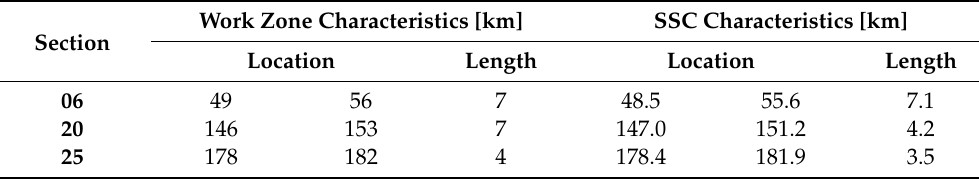
Table 2. Basic characteristics of studied work zone and SSC sections.